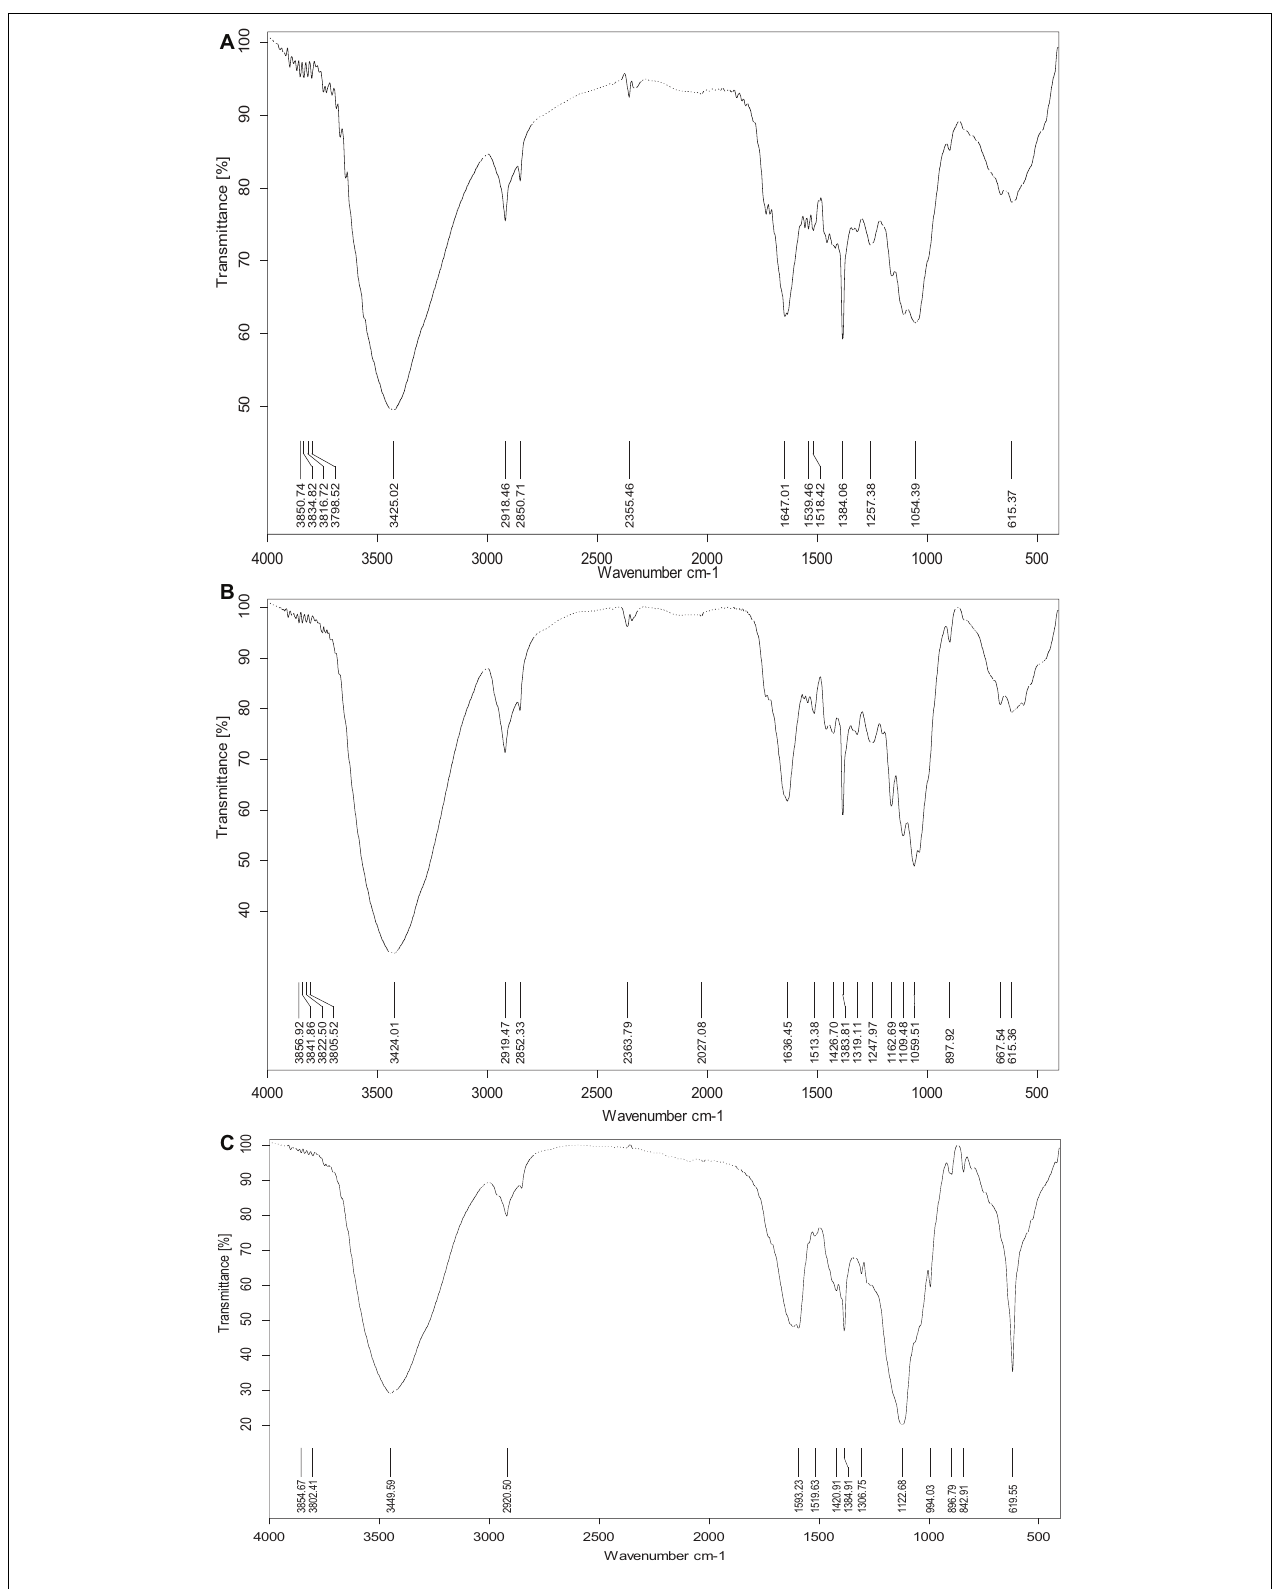
FIGURE 4 | FTIR spectroscopy of (A) untreated Phragmites karka , (B) acid-pretreated P. karka , and (C) saccharified Phragmites karka.